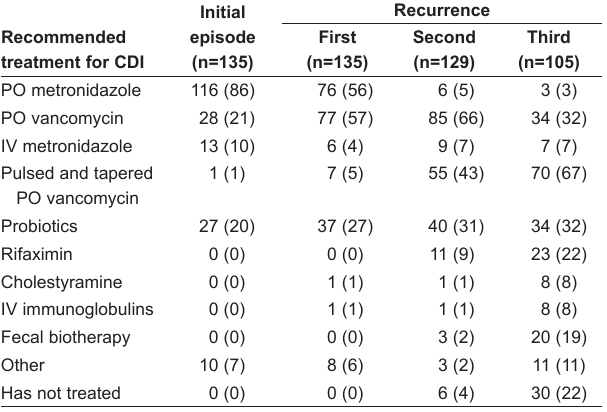
TAble 2 Physician experience with Clostridium difficile